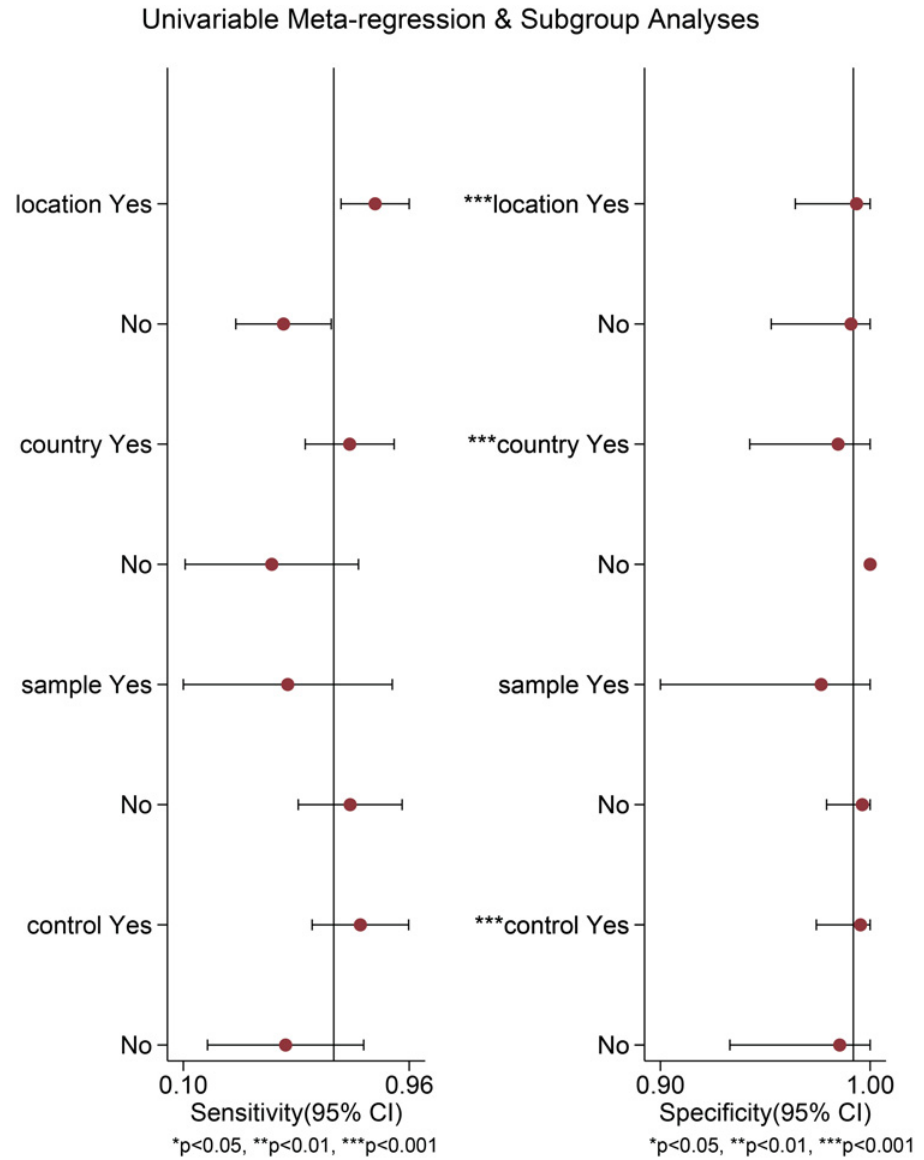
Fig 6. Univariate meta-regression for the sensitivity and specificity of ALK for IMT